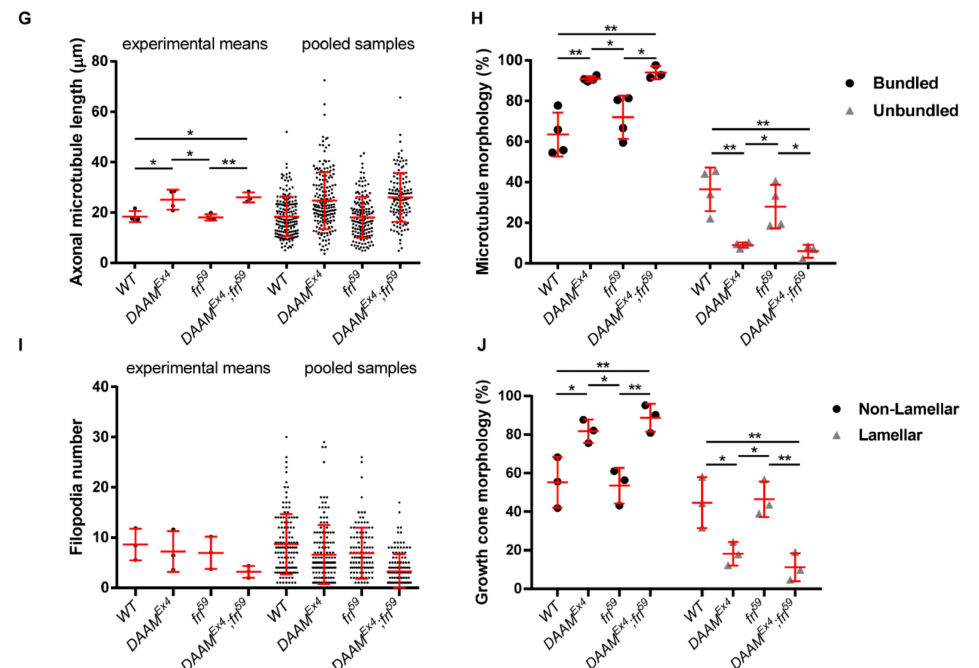
Figure 2. Morphological analysis of primary neurons derived from DAAM and frl single- and double- mutant embryos. ( A – D (cid:48)(cid:48) ) Representative images of primary neurons derived from wild-type ( A – A (cid:48)(cid:48) ), DAAM Ex4 ( B – B (cid:48)(cid:48) ), frl 59 ( C – C (cid:48)(cid:48) ) and DAAM Ex4 ; frl 59 ( D – D (cid:48)(cid:48) ) embryos. The actin cytoskeleton was labelled by phalloidin (green); microtubules were visualized by an anti-tubulin (magenta) antibody. Scale bar represents 5 µ m. ( E – F (cid:48)(cid:48) ) Examples for cytoskeleton organization of axonal growth cones labelled by phalloidin (green) and anti-tubulin antibody (magenta). Scale bar represents 5 µ m. ( G ) Statistical analysis of axonal length of axonal microtubule bundles. Scatter plots show the values of the individual cells and the means of the independent experiments. ( H ) Scatter plots show the frequency of microtubule morphologies in the growth cone. ( I ) Statistical analysis of the axonal filopodia numbers. Scatter plots represent the values of the individual cells and the means of the independent experiments. ( J ) Scatter plots show the frequency of growth cone morphologies labelled by phalloidin. ANOVA was used for statistical analysis. Tukey’s post hoc test was used for multiple comparison. * p < 0.05, ** p <